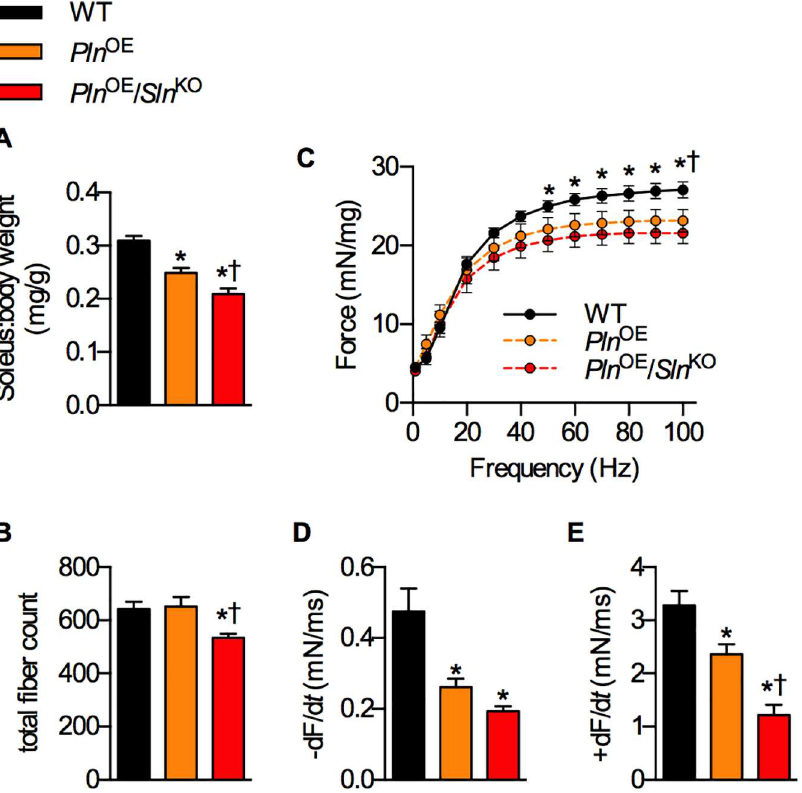
Fig 4. Without SLN upregulation, Pln OE soleusmusclesaresmallerand weaker. (A) soleus:body weight ratios(mg/g)across genotype (n = 18–23pergenotype). (B) Total myofibercount in soleusmusclesections countedafter immunofluorescentstaining(n = 6 pergenotype).(C) Mass-specificforce-frequencycurveanalysis in isolatedsoleusmuscles(n = 6–7pergenotype).Ratesof relaxation(-dF/dt, D) andforce development (+dF/dt, E) measured for a singletwitch (n = 6–7pergenotype).For (A, B, D andE), * significantly differentfrom WT; † significantlydifferent from Pln OE, usinga one-wayANOVA p (cid:20) 0.05.For C, * significantly differentfrom Pln OE / Sln KO ; † significantlydifferentfrom Pln OE, usinga two-wayANOVA p (cid:20) 0.05.All valuesaremeans ±